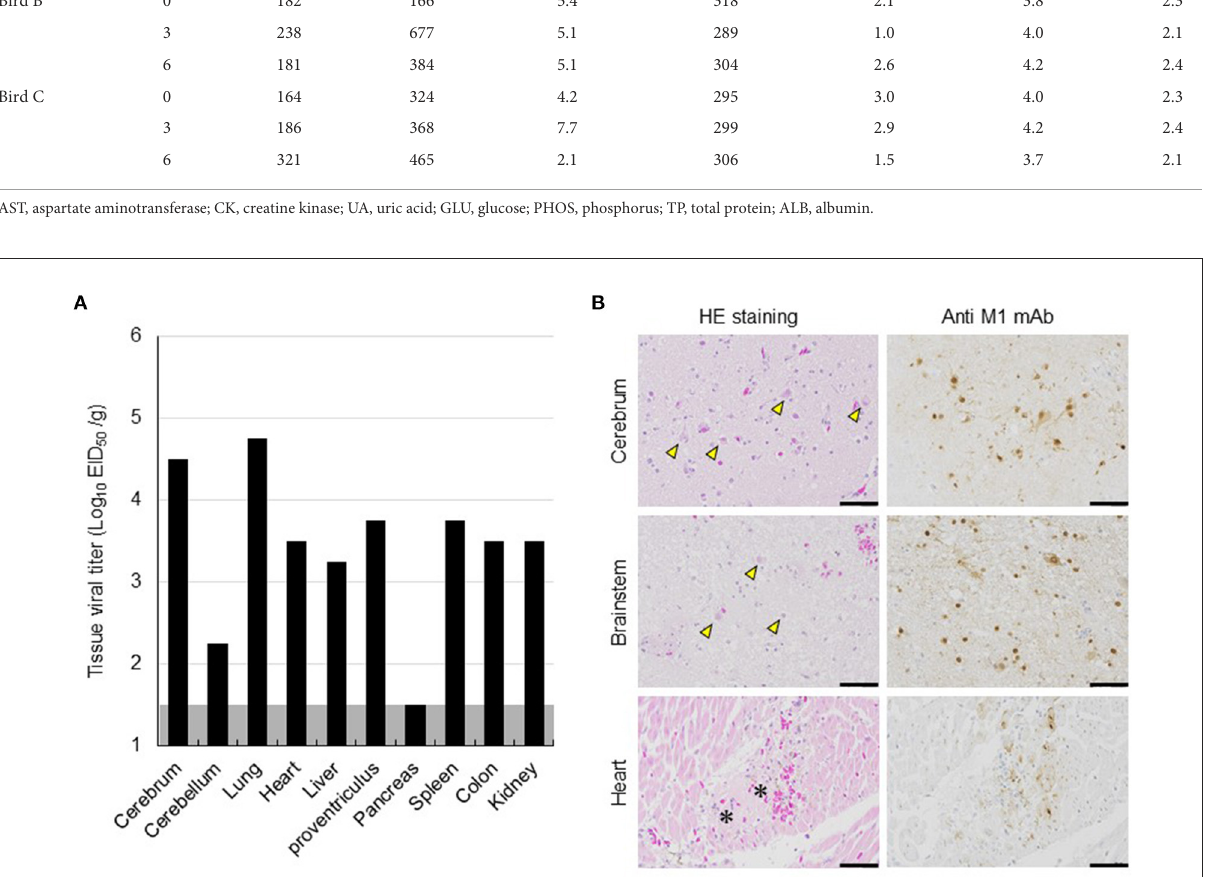
FIGURE2 Viral replication and histopathological lesions in organs from a dead white-tailed sea eagle naturally infected with H5N8 HPAI virus. (A) Viral titers in organs from the dead white-tailed sea eagle. Organs were collected, homogenized, and subjected to virus titration in embryonated chicken eggs. The detection limit was below 1.5 log EID 50 /g. (B) Histopathological findings in the dead white-tailed sea eagle. Sections from the cerebrum, brainstem, and heart of the dead white-tailed sea eagle were stained with hematoxylin and eosin (HE staining) and